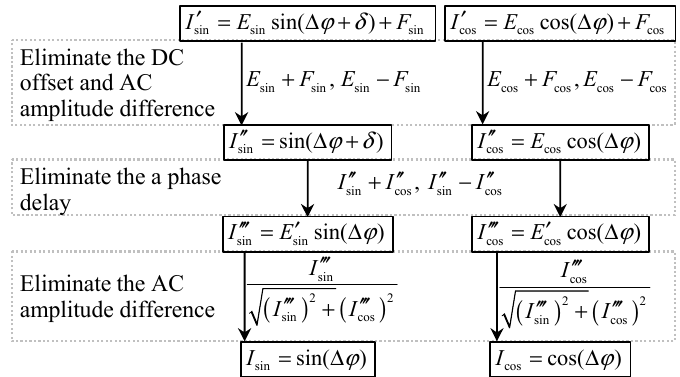
Figure 4. Flowchart of the elimination of the nonlinear errors.